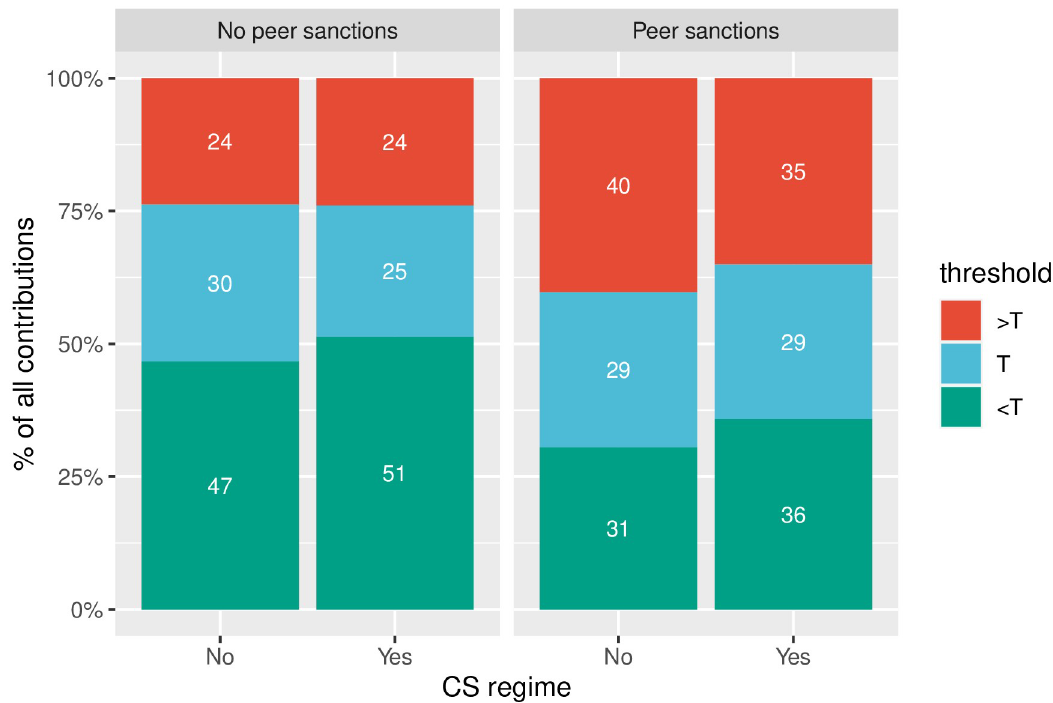
Fig 4. Share of compliers and non-compliers across